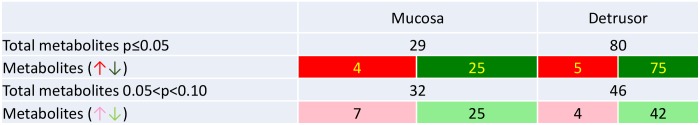
Number of metabolites with significantly changed levels after iberiotoxin treatment.Note: the following key is used for throughout the Figs in the paper: Dark Green Background: Indicates significant (p≤0.05) down-regulation of metabolite following IBTX treatment; Light Green Background: Indicates a trend/narrowly missed statistical significance (0.05<p<0.10) for down-regulation of metabolite following IBTX treatment; Dark Red Background: Indicates significant (p≤0.05) up-regulation of metabolite following IBTX treatment; Light Red Background: Indicates a trend/narrowly missed statistical significance (0.05<p<0.10) for up-regulation of metabolite following IBTX treatment. Grey Background: Indicates a detected metabolite which was unchanged following IBTX treatment. White Background: Indicates an undetected metabolite which is part of the metabolic pathway.